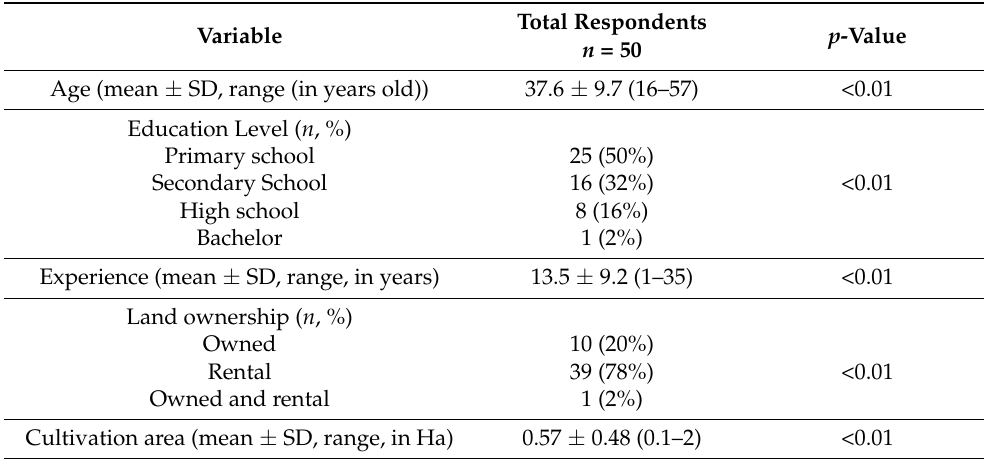
Table 1. Demographic characteristics of